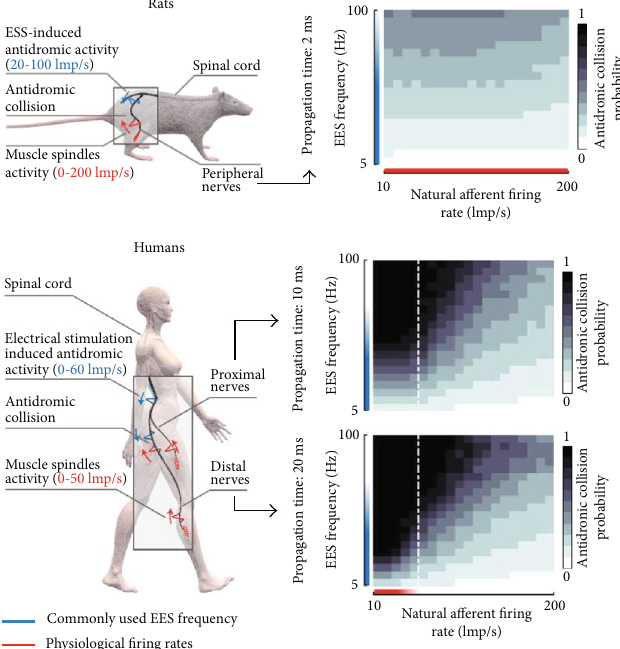
Figure 3: Probability of retrograde AP in sensory a ff erent fi bers under EES.